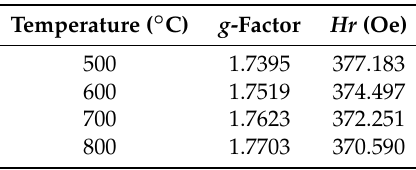
Figure 10. Nanoparticle ESR spectra at calcination temperatures of 500 ◦ C ( a ), 600 ◦ C ( b ), 700 ◦ C ( c ), and 800 ◦ C ( d ). Table 3. Magnetic parameters of SnO 2 nanoparticles observed for ESR